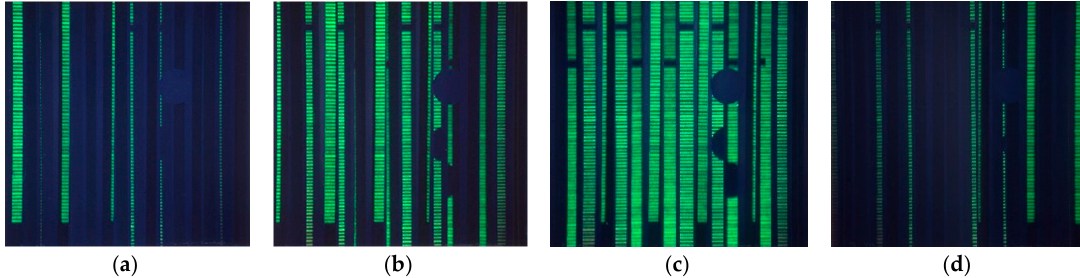
Figure 6. ( a ) Far left view of hologram, ( b ) left of center view of hologram ( c ) center view of hologram ( d ) far right view of hologram.